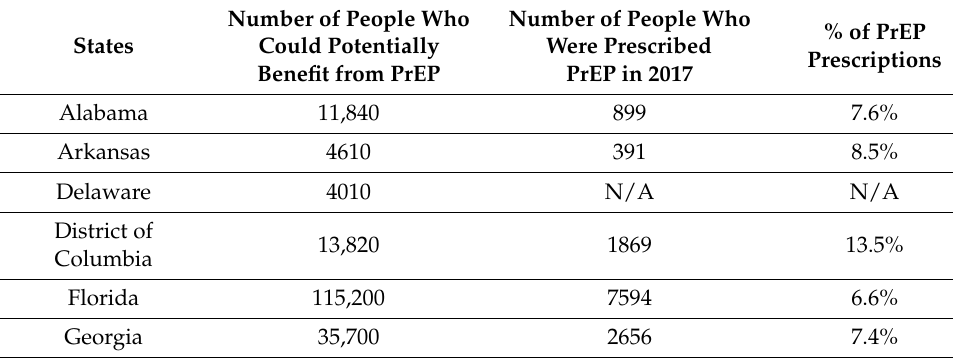
Table 3. Number of PrEP prescriptions in Southern States in